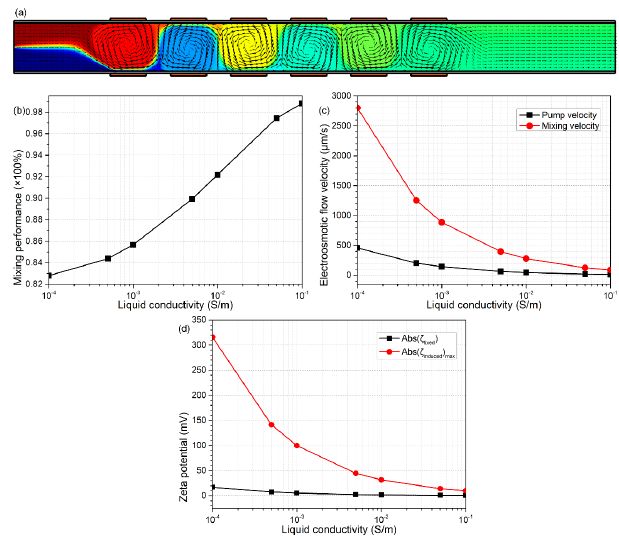
Figure 8. Effect of liquid conductivity σ f on the device performance for sextuple-alternated B-DCFFET, for given values Vs = 70 V, V G1 = − V G2 = 700 V, L G = 150 μm and L GG = 100 μm. ( a ) An arrow and surface plot of the electroosmosis flow field and resulting molar concentration distribution of chemical analyte (unit: mol/m 3 ) with σ f = 0.005 S/m. ( b ) σ f -dependent mixing efficiency. ( c ) Electroosmotic flow velocity in terms of pump and mixing fluid motions at varying liquid conductivities σ f . ( d ) A quantitative comparison between the magnitude of native zeta potential at the membrane/solution interface, as a function of the medium conductivity σ f .